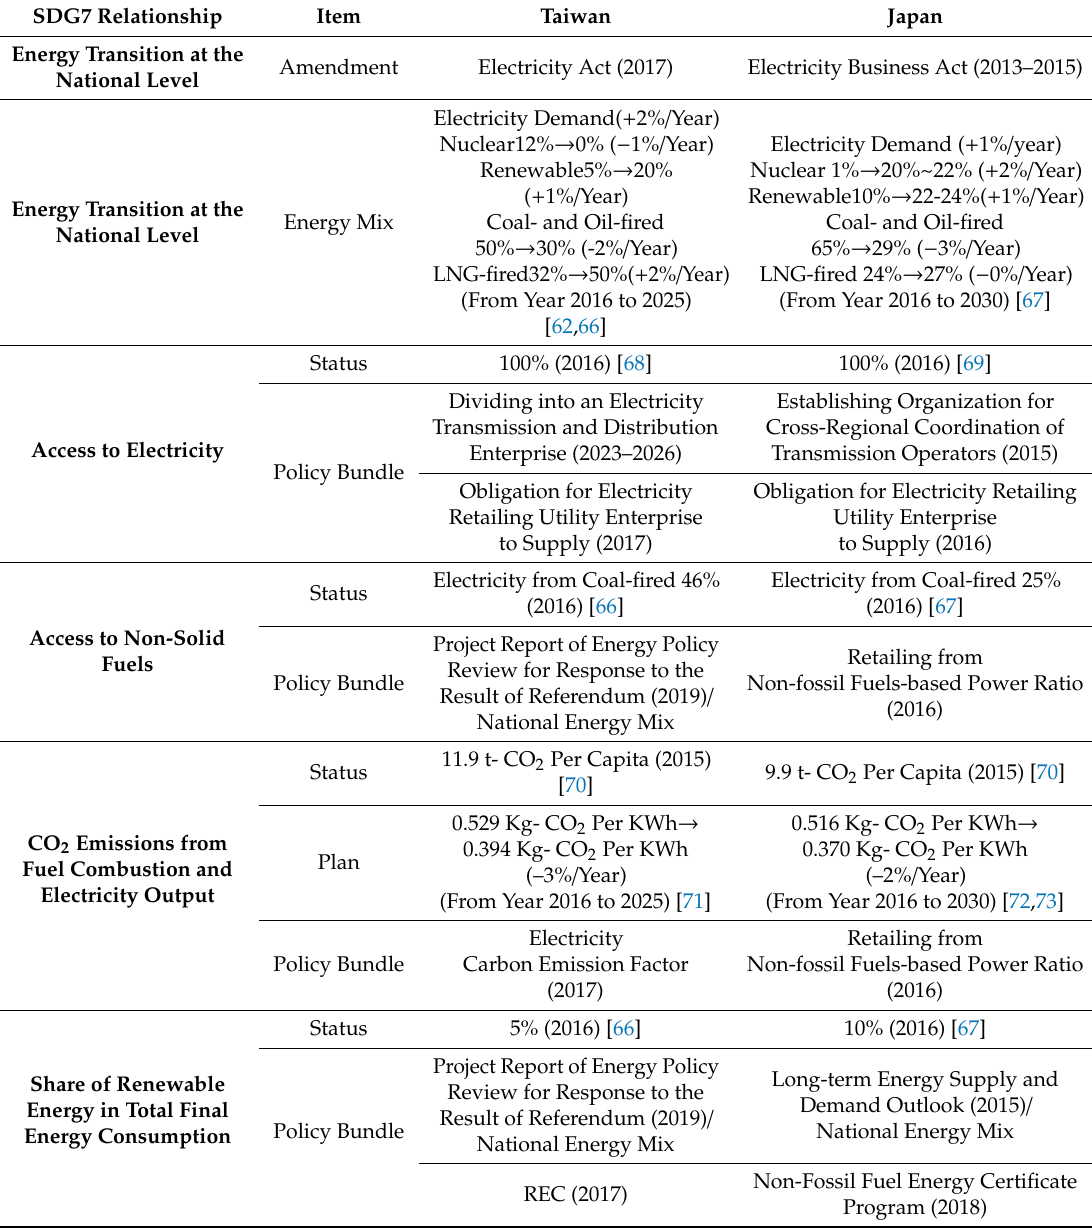
Table 3. A comparison of the seventh Sustainable Development Goal (SDG7) relationship and energy transition between Taiwan and Japan, based on the similar initiative of Electricity Act with policy